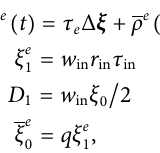
/ τ (cid:1) 0 . 2. 1 e